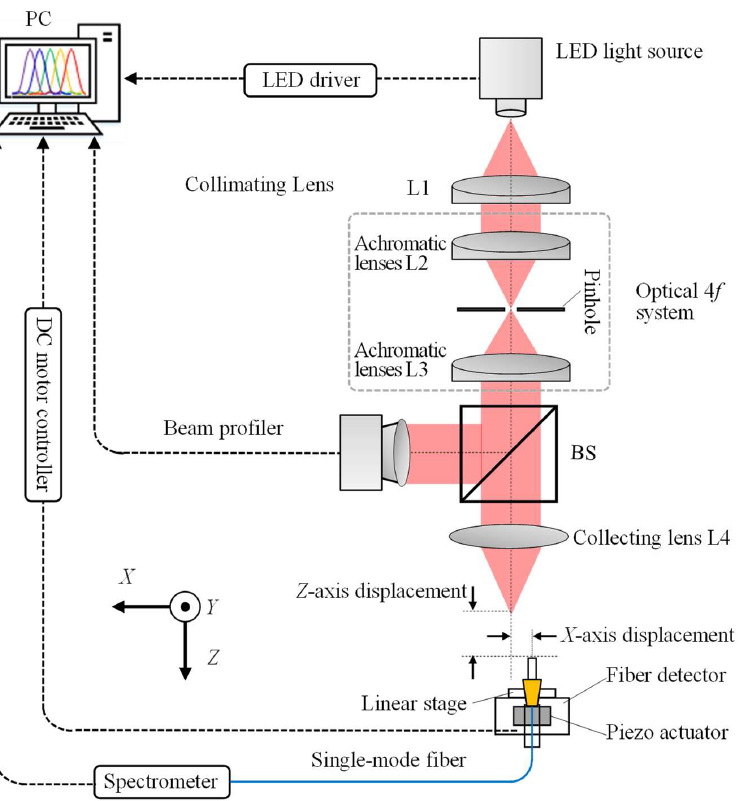
Figure 7. Schematic of the fiber-based chromatic dispersion probe for simultaneous measurement of the X -axis and Z -axis displacements with nanometric resolutions. Table 1. Physical parameters of the dispersive lens. Items Symbol